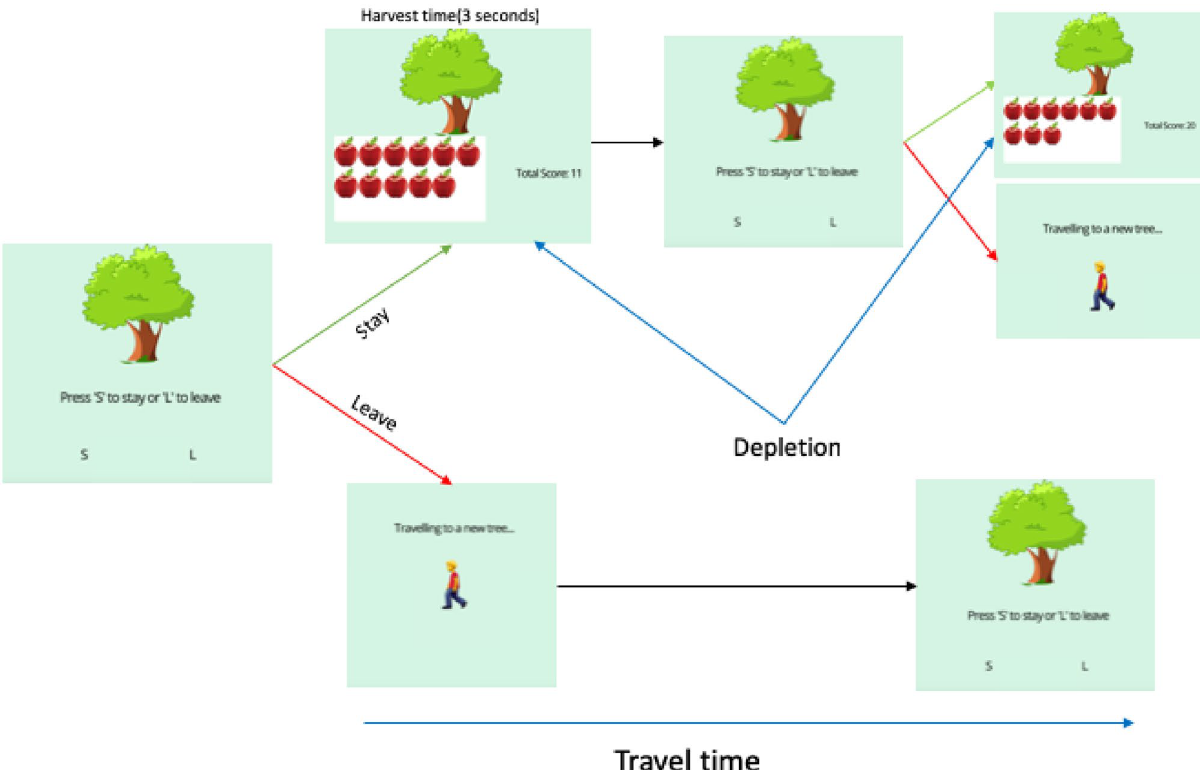
Figure 5. Outline of the patch foraging task. Participants who chose to stay (top panel) are presented with the number of apples they collected on that trial before being returned to the tree. Participants who chose to leave (bottom panel) are presented with a screen for six seconds before arriving at a new